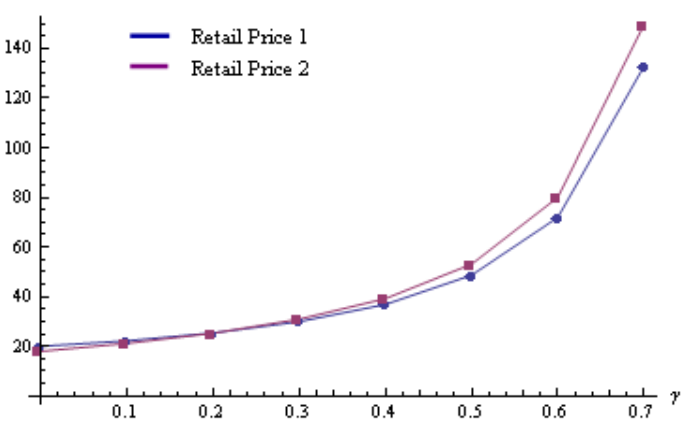
Figure 7. The impact of the intensity of price competition on retail prices.